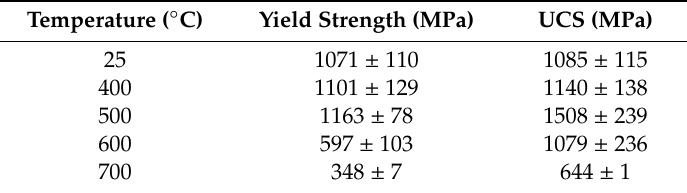
Table 3. Mechanical properties (yield strength and ultimate compressive strength) of FeAl20Si20 alloy in compression.